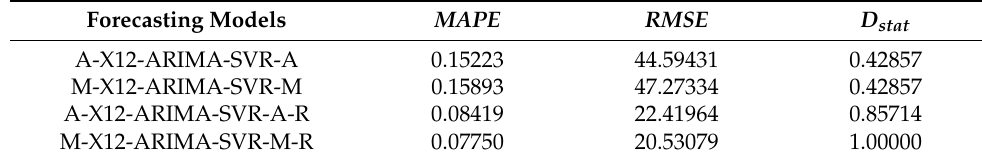
Table 5. The prediction performance of gasoline consumption in